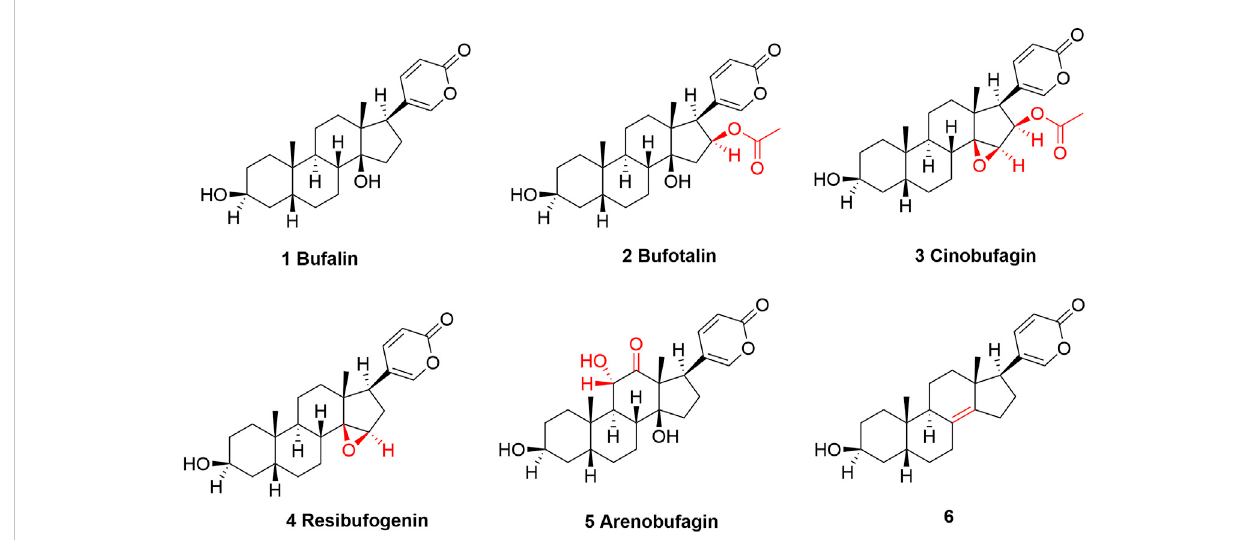
The structures of bufalin and its derivatives found in toad venom which show cancer-suppressing effects. Structurally, bufalin can be regarded as a parent compound, and all other TVAs are modi fi ed on bufalin at different positions. The structural differences are highlighted in